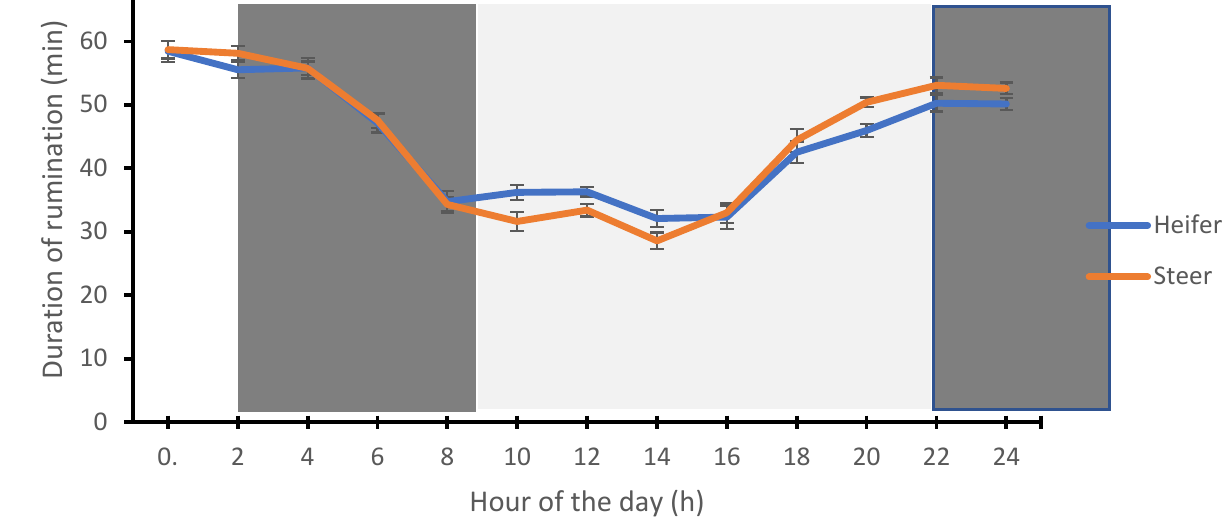
(14:00 h) (Figure 1). The time spent on activity behavior by the heifer (30.14 ± 1.04 min) and steer (31.67 ± 01.52 min) were highest ( p < 0.0001) during the afternoon period (16:00 h) and lowest (17.86 ± 0.88 min and 17.71 ± 0.76 min) during the night period (02:00 h) (Figure 2).